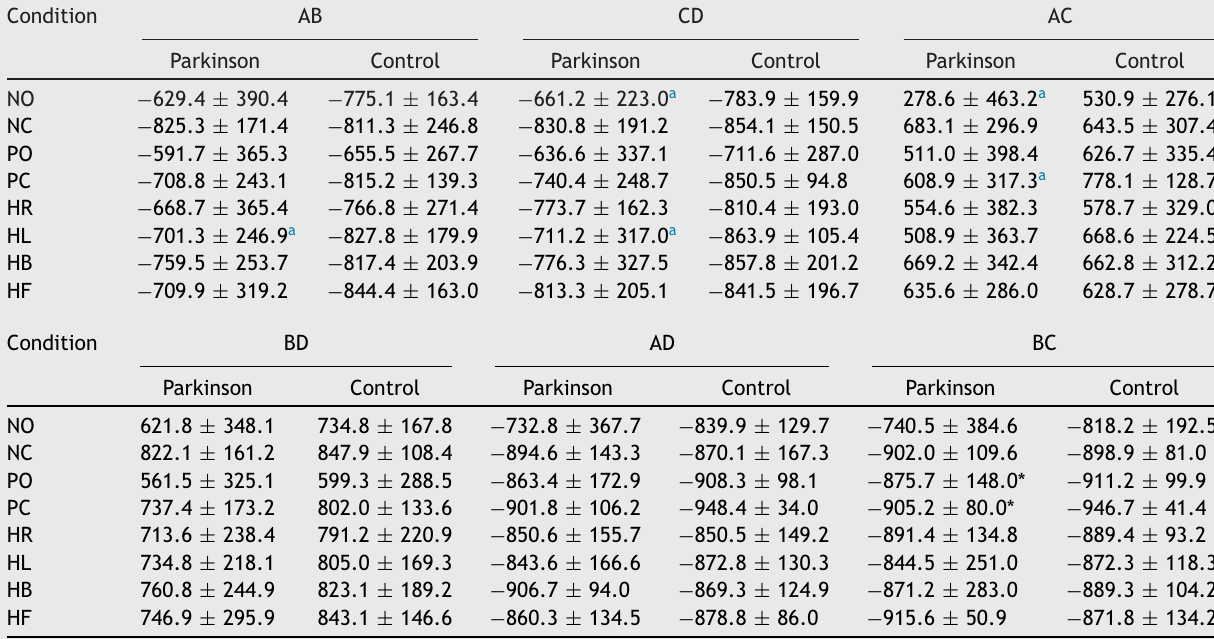
Comparative analysis of synchronization indexes in the eight conditions of the Tetrax TM interactive balance system in 29 control subjects and 30 patients with Parkinson’s